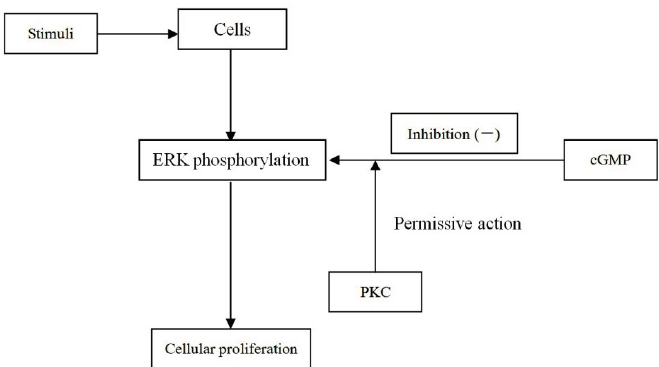
Figure 8. The algorithm showing the permissive action of